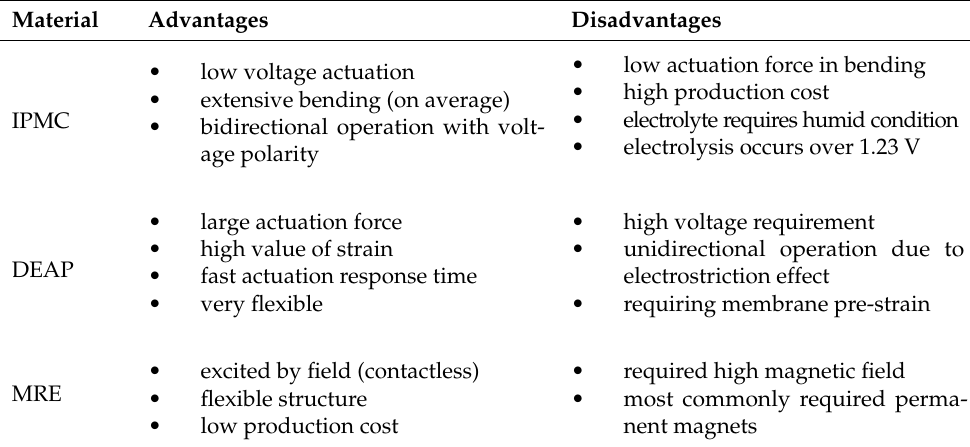
Table 1. Advantages and disadvantages of IPMCs, DEAPs, and